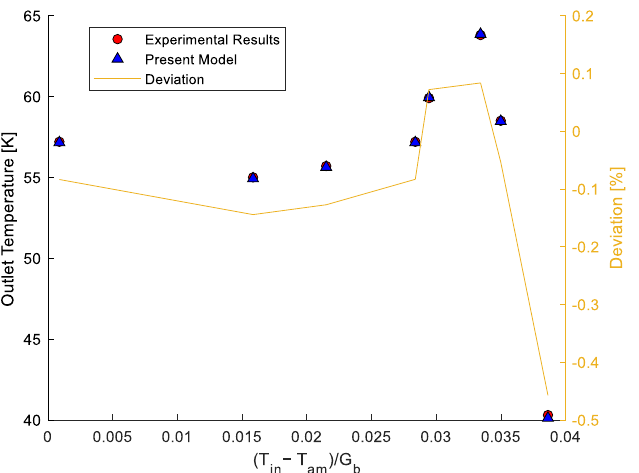
Figure 2. Validation of the present model against the experimental results reported by Tagle et al. [63].